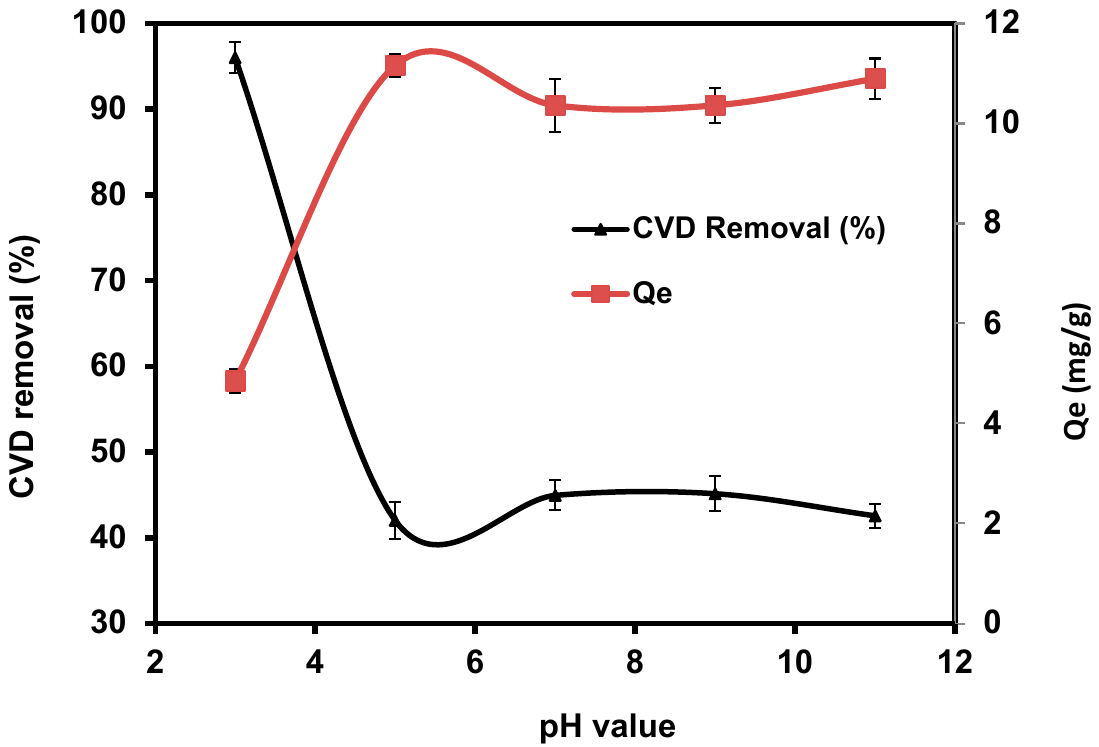
Figure 5. Impact of pH values on the adsorption of CVD onto S. costatum . Dye removal efficiency decreased when the pH increased from 5 to 11, indicating that pH did not significantly affect the percentage of CVD removal, particularly under alkaline conditions. The highest percentage of CVD uptake was obtained at pH 3, with a percentage removal of 96%. CVD is based on chromophores combined with several kinds of reactive groups that react with the active functional groups of S. costatum , such as chitin, carboxyl, hydroxyl, acidic polysaccharides, amine, and the other functional groups [57,59]. Higher removal observed at low pH values is perhaps attributed to the electrostatic appeal between negatively charged CVD anions and positively charged S. costatum cell surface